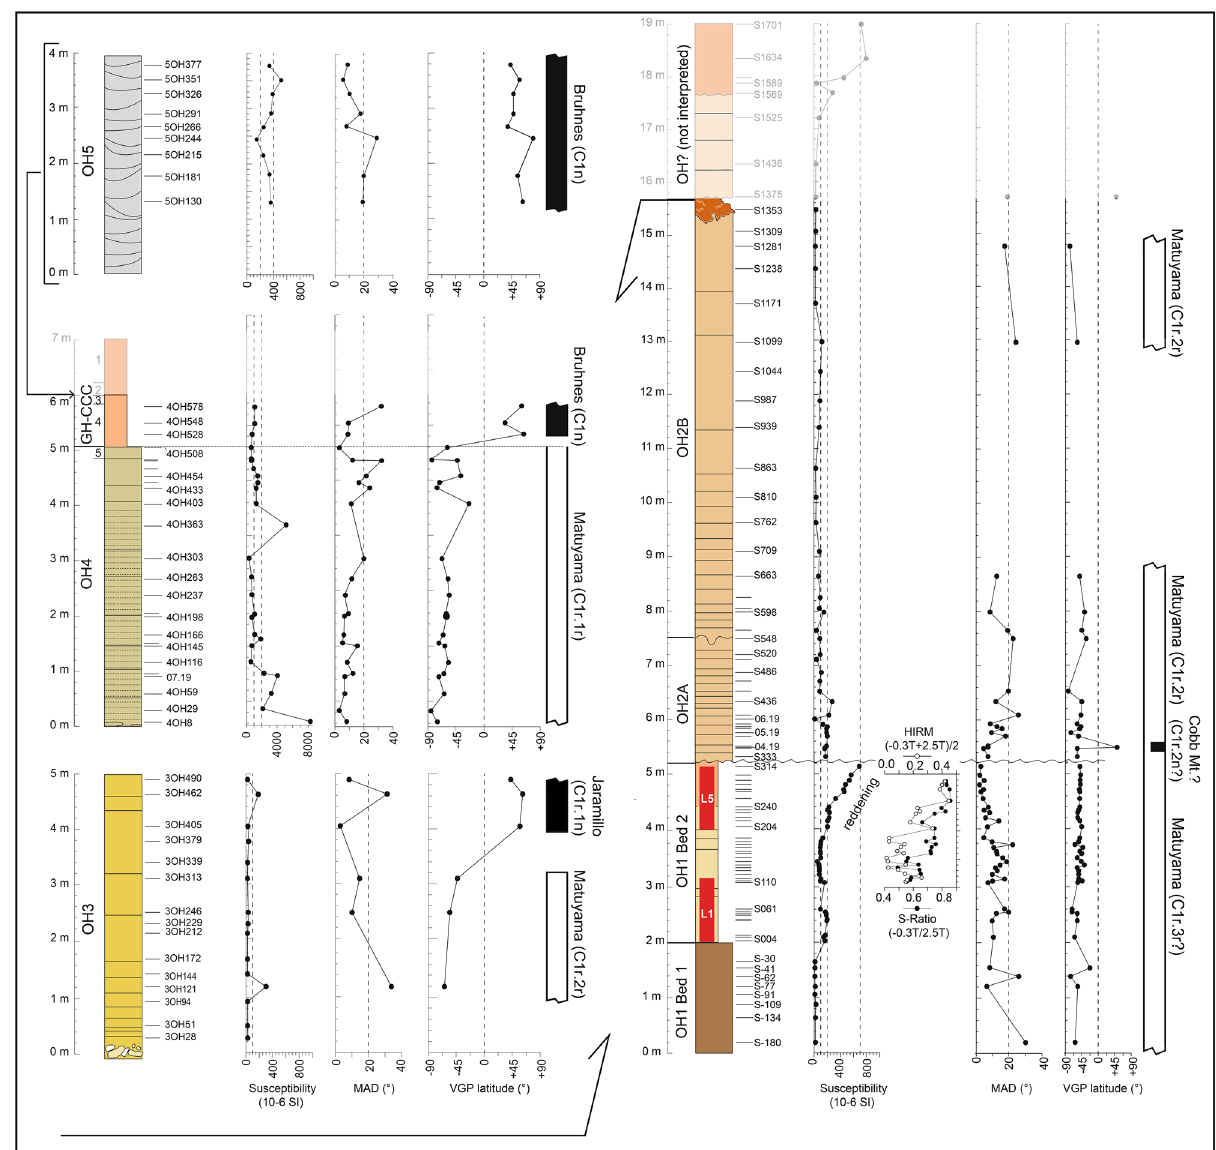
Figure 5. Generalized logs of the stratigraphic sections investigated (youngest at top left, oldest at bottom right, but see description for details) with indication of paleomagnetic samples placed aside initial magnetic susceptibility, maximum angular deviation (MAD) values of the C component directions, virtual geomagnetic pole (VGP) latitudes, and polarity stratigraphy where black bars represent normal polarity and the white bar is reverse polarity. Cobb Mt.? is a possible record of the Cobb Mountain subchron. Red bars indicate archeological units ThI-L1 (bottom) and ThI-L5 (top) within OH1 Bed 2. Drawing G. Muttoni, S. Perini, and S. Sanz- Laliberté. This figure was created with Adobe Illustrator CS6 version (http:// www. adobe.